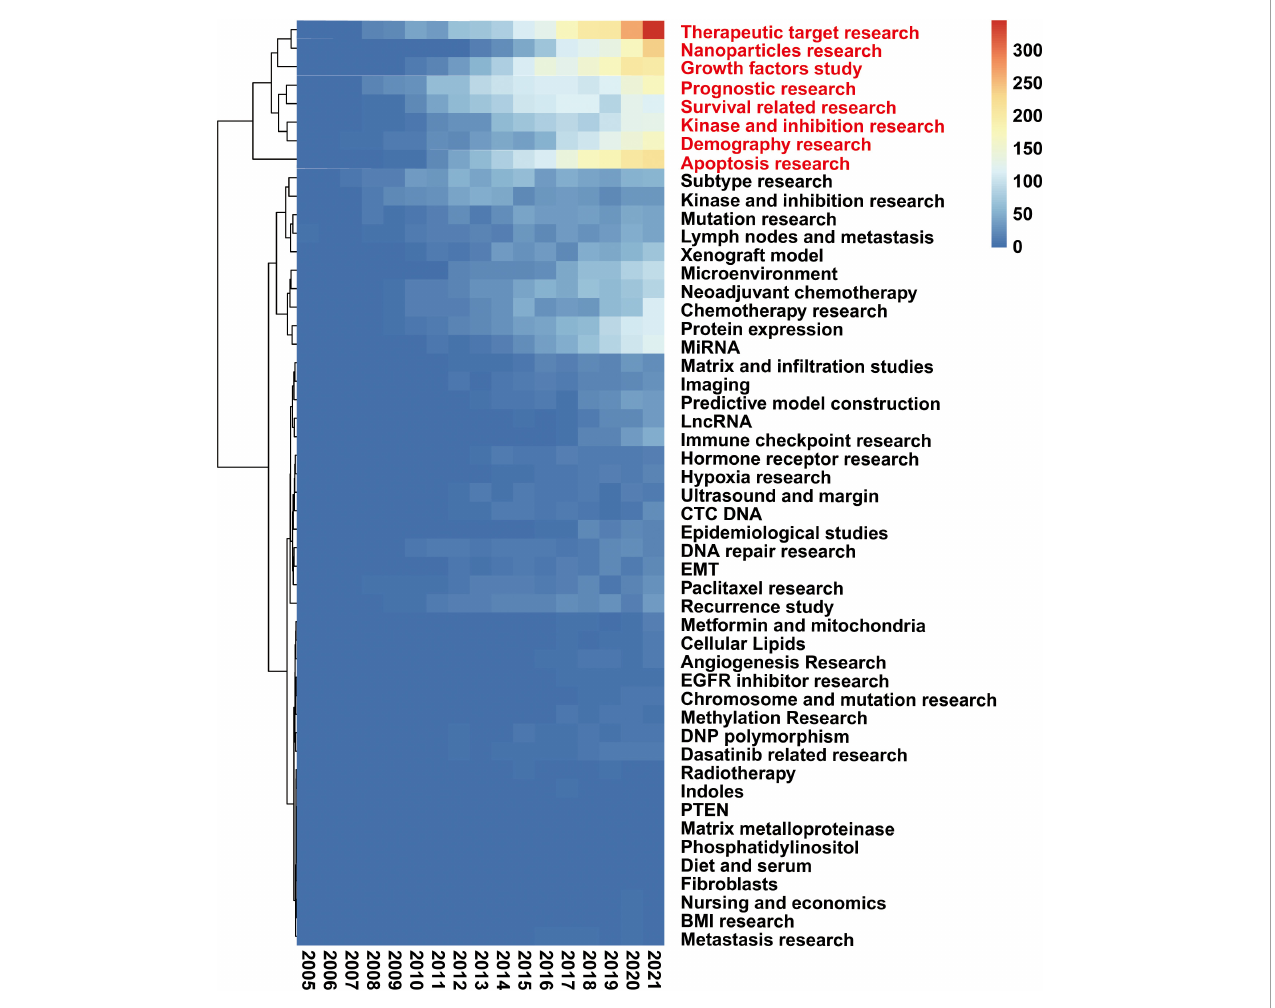
FIGURE6 Therapeutic target research and Nanoparticles research are research focus. Heatmap presents the change of 50 research topics of triple-negative breast cancer (TNBC). Latent Dirichlet Allocation (LDA) generated all data. The topics marked in red are the research focus. The lighter the color in the figure, the more